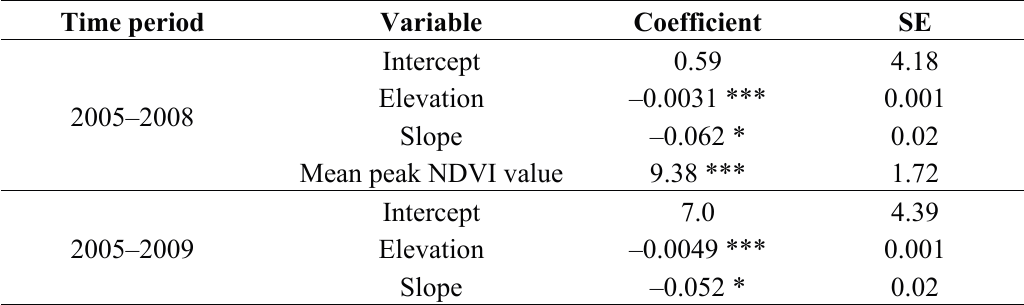
Table 5. Results of the logistic regression modeling of the low and high interannual variability of peak NDVI timing from 2005–2008 and 2005–2009 for 800 random point locations across the ponderosa pine ecosystem. * p < 0.05; *** p <